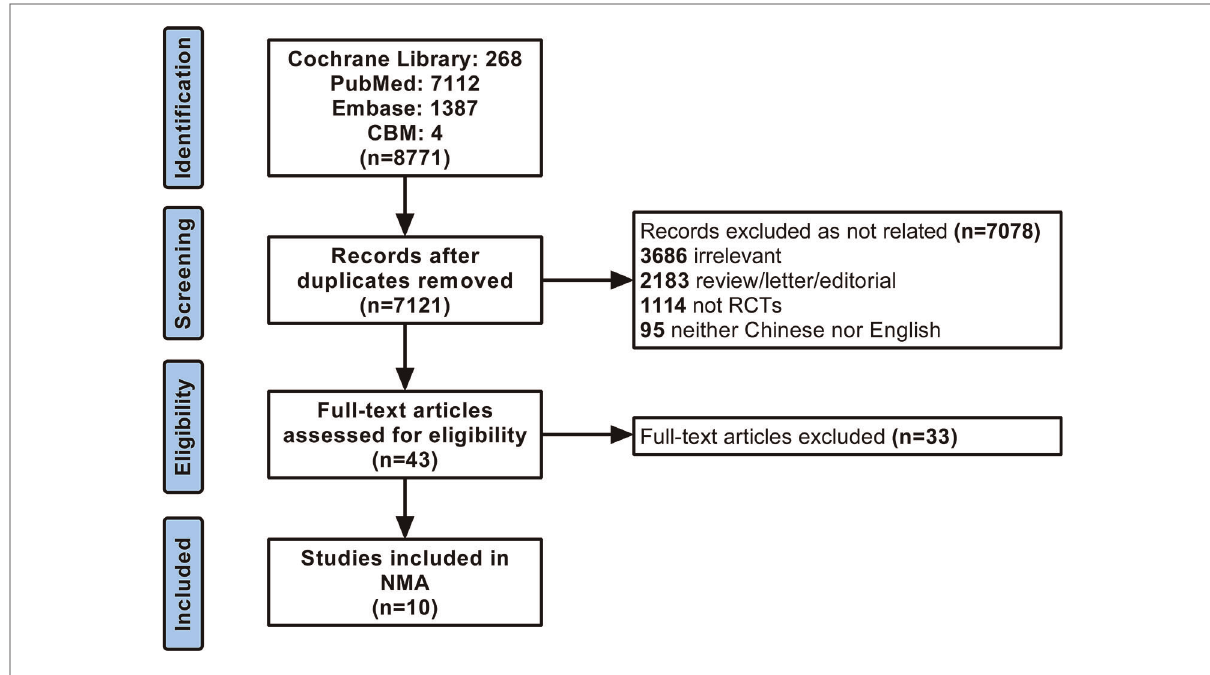
FIGURE 1 Flow chart of the literature search and selection of studies.